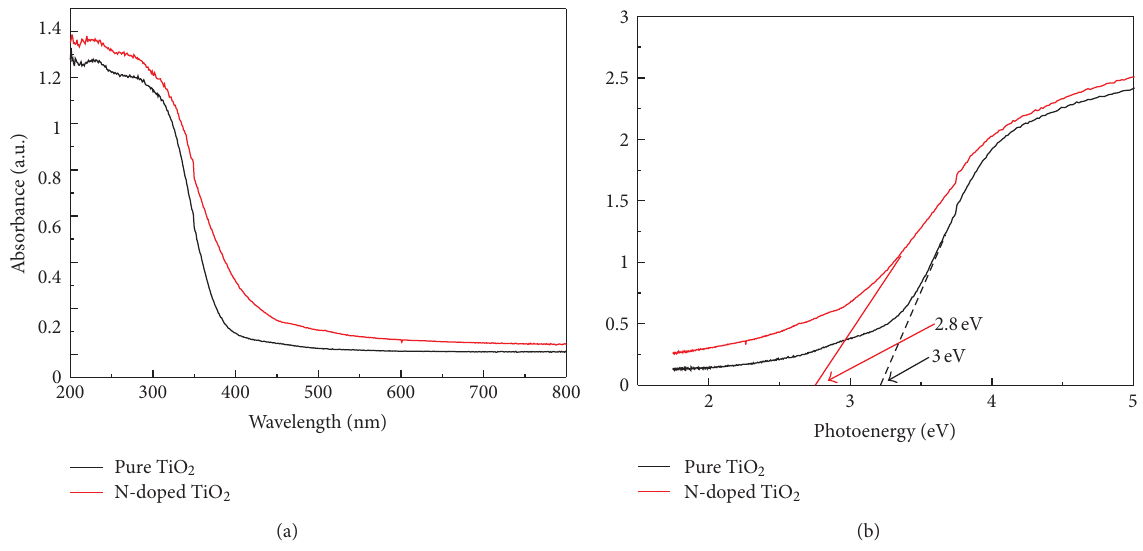
F4:UV-visabsorptionspectroscopyofundopedandN-dopedTiO